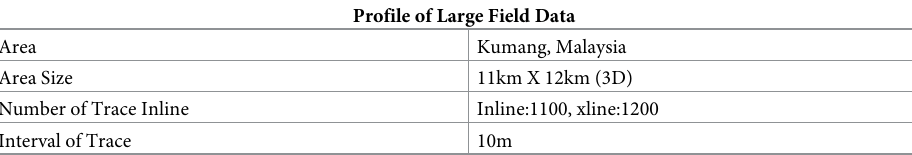
Table 4. Large field